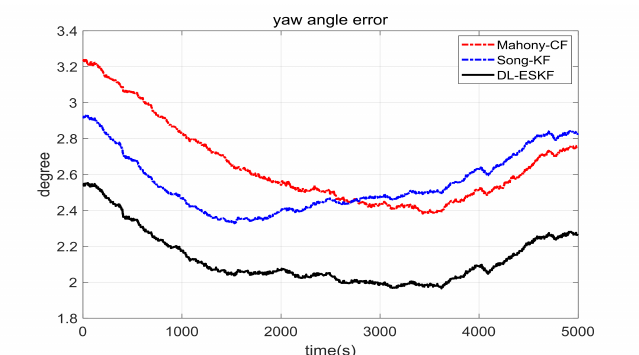
Figure 6. Pitch angle error under static conditions.